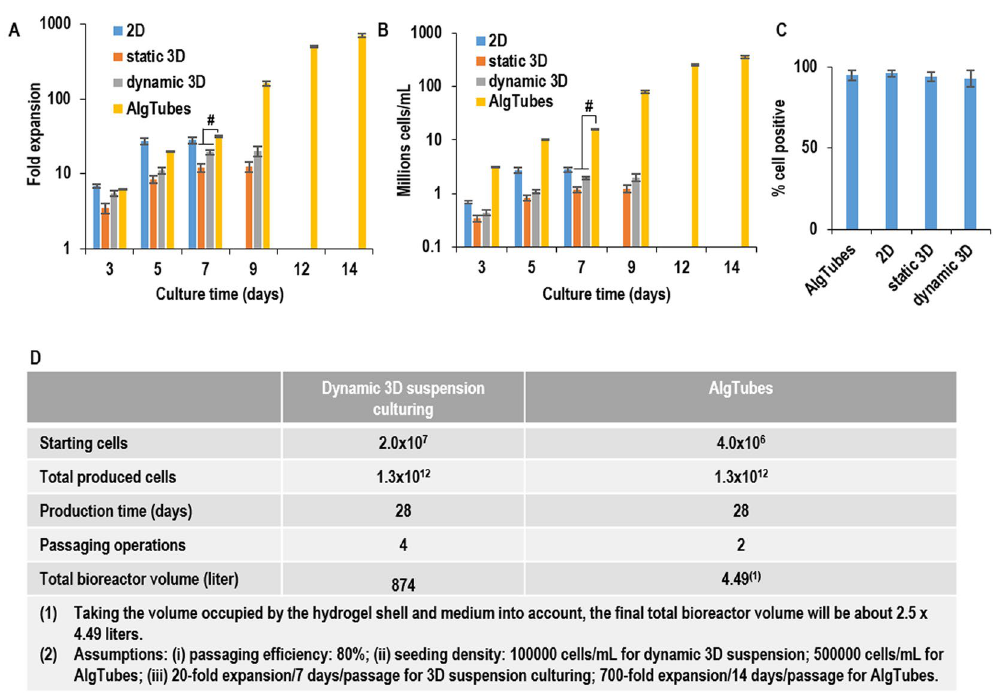
Figure 7. Comparing culturing glioblastoma TICs in AlgTubes, 2D culturing, static 3D and dynamic 3D suspension culturing. Glioblastoma TICs (L0) were seeded at 1 × 10 5 cells/well (of 6-well plate) and cultured for 7 days in 2D culturing; seeded at 1 × 10 5 cells/mL and cultured for 9 days in static 3D and dynamic 3D suspension; seeded at 5 × 10 5 cells/mL and cultured for 14 days in AlgTubes. ( A ) The expansion fold, ( B ) volumetric yield and ( C ) % cell Nestin + cells in the culture were quantified. ( D ) A comparative calculation of producing 1.3 × 10 12 glioblastoma TICs. In a bioprocess using dynamic 3D suspension culturing (e.g. with stirred tank bioreactor), 1.3 × 10 12 TICs are generated through series expansions of 2.0 × 10 7 cell seeds with 4 passaging operations in 28 days. The total culture volume is ~874 liters. In a bioprocess using AlgTubes, 1.3 × 10 12 TICs are generated from 4.0 × 10 6 seeds with 2 passaging operation in 28 days. Total of 4.49 liters AlgTubes are needed. # P < 0.05. Data are presented as mean ± SD of three replicates (n = 3). Note for 2D culturing, the unit for cell density in ( B ) is cells/well (of 6-well